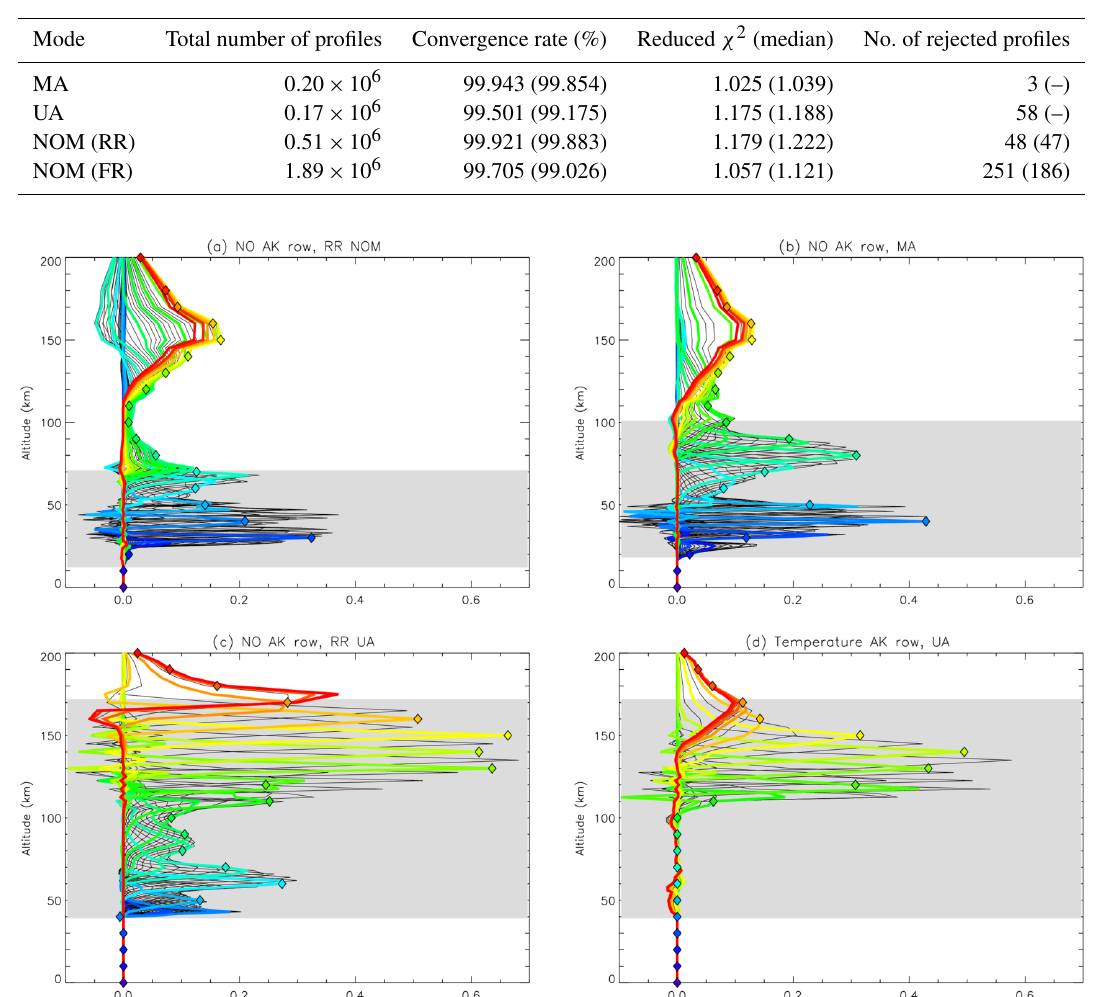
Table 3. Number of retrieved profiles, the convergence rate, the median value of the reduced χ 2 , and the number of rejected profiles for the version 8 MA, UA, NOM RR, and NOM FR datasets. Numbers in brackets refer to the corresponding values for version 5 datasets.